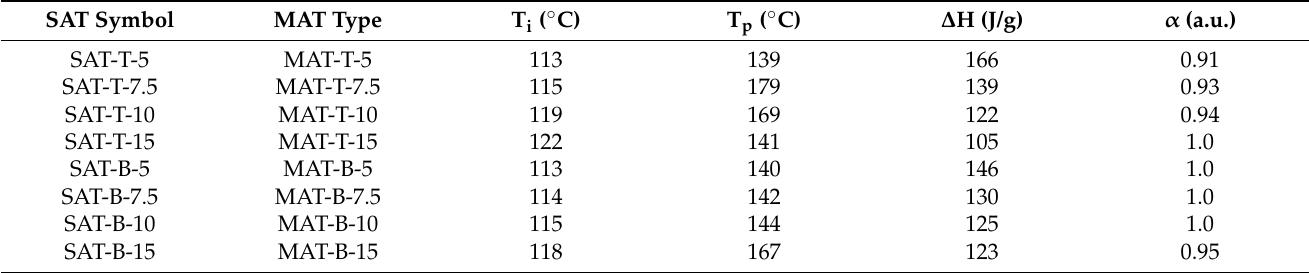
Table 3. Thermal parameters of the UV-crosslinked SATs (DSC data) and the crosslinking degree ( α ) of the thermally cured SATs. SAT Symbol